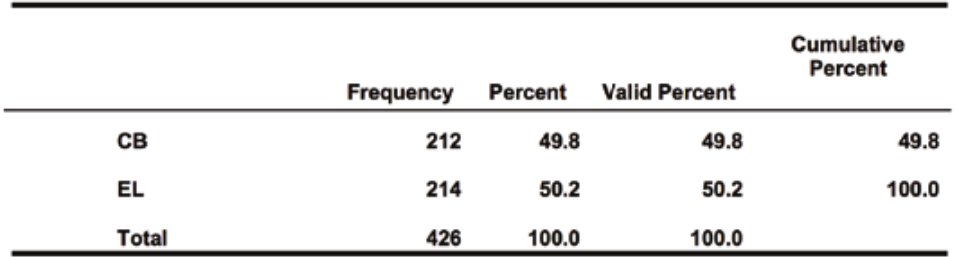
Table 1: Frequency Table for Mode of Study